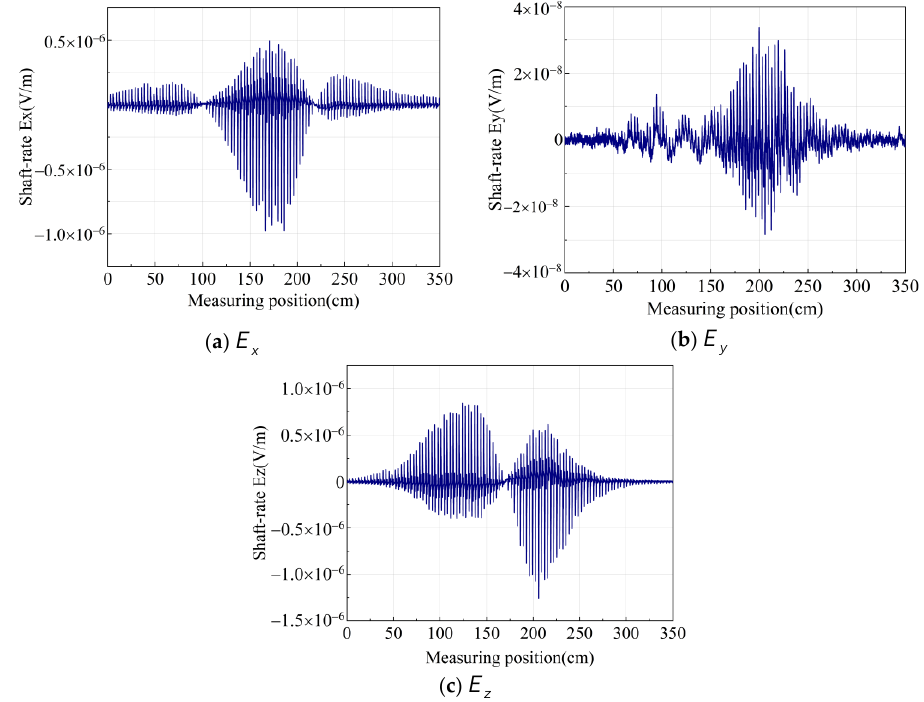
Figure 14. Distribution of XYZ components of the experimental shaft-rate electric field.